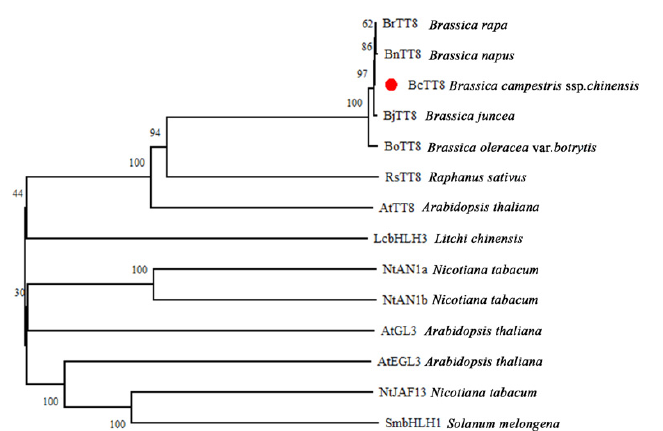
Figure 5. The phylogenetic tree of BcTT8 protein in non-heading Chinese cabbage and similar bHLH proteins in other species. The protein labeled with a red dot was BcTT8. Gene bank number BrTT8